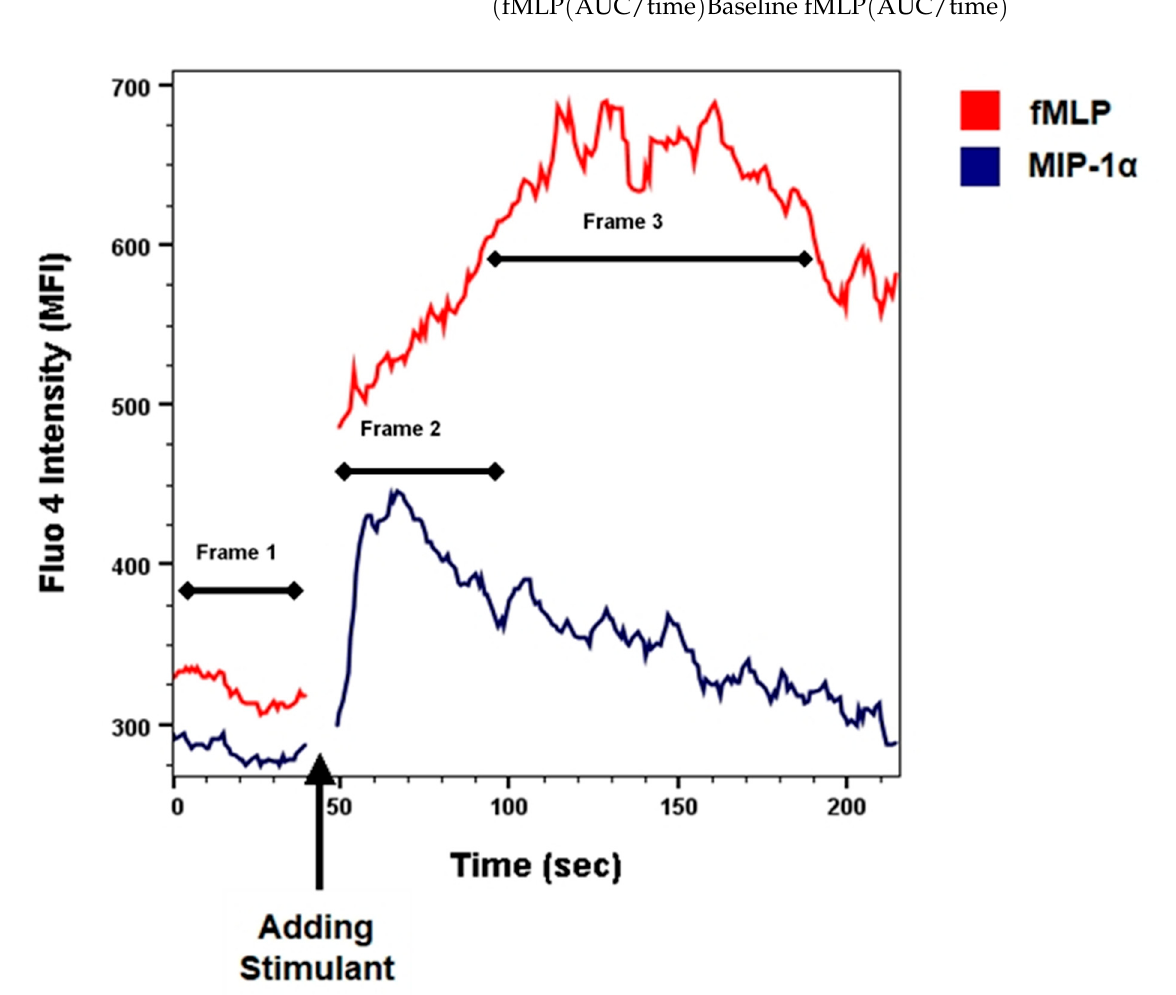
Figure 1. Flow cytometric analyses of kinetic changes in [Ca 2+ ] i in monocytes after stimulation with fMLP (5.0 nmol) or MIP-1 α (3.8 pmol), in one representative patient. The arrow indicates the moment of adding the stimulant. The limiting factor in the monocyte calcium mobilization experiments was the number of cells available. For every patient ( n = 21), two different stimuli were used: MIP-1 α and fMLP. The number of cells available did not permit to perform replicates.